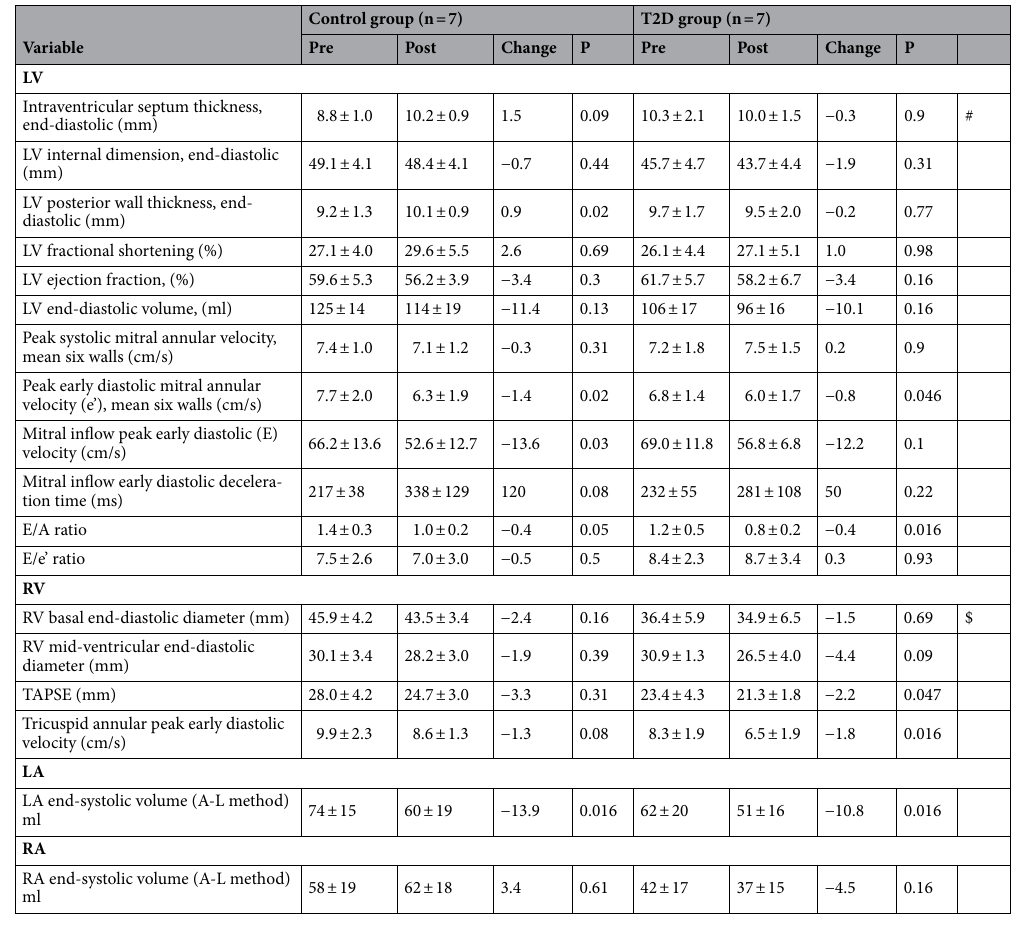
Table 2. Echocardiography alterations by exercise training. Data are mean ± SD. All presented tissue Doppler velocities are recorded by color tissue Doppler, except for E/e’ ratio, which includes the average of septal and lateral e’ measured in pulsed-wave tissue Doppler recordings. E/A ratio peak early mitral inflow to late diastolic velocity, E/e’ ratio peak early mitral diastolic inflow velocity (E) to early diastolic mitral annular velocities (e’), A-L area-length, TAPSE tricuspid annular plane systolic excursion, LA left atrium, RA right atrium, LV left ventricle, RV right ventricle. The indicated p-value is the statistical difference between pre- and post-exercise values within each group. # Significantly different responses from pre- to post-exercise between the T2D and control groups (p < 0.05). $ Significant difference between T2D and control groups at baseline recordings before exercise (p <